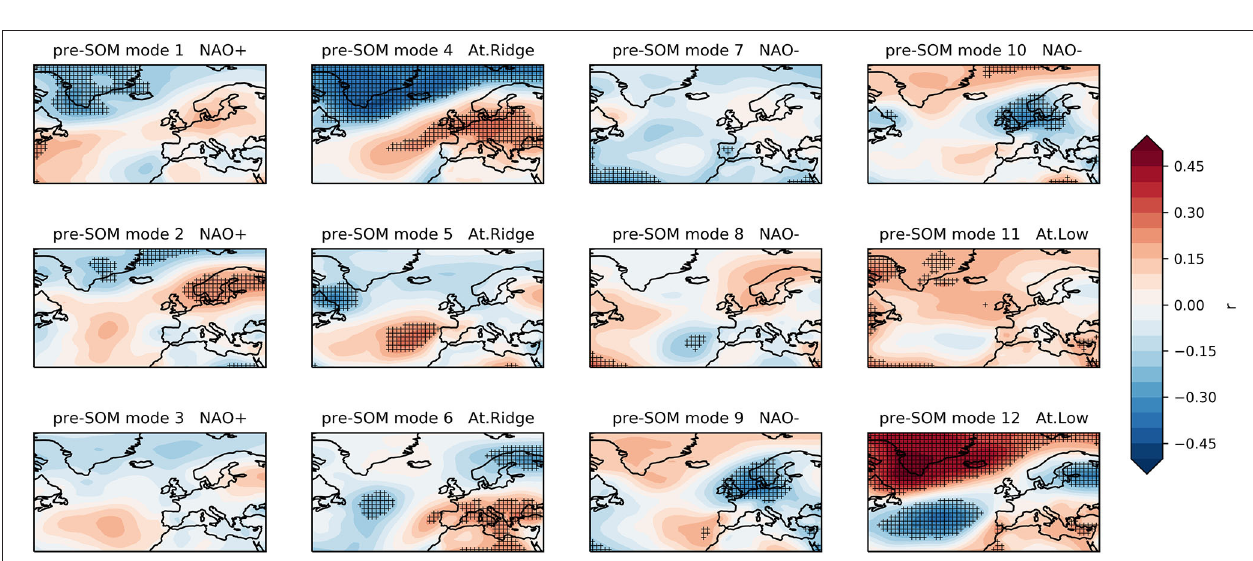
FIGURE 4 | Spring sea surface temperature (April SST) predictor patterns in the reanalysis with respect to the SOM master ( Figure 2 ), for the period 1902–2008. Each pattern of SST precedes a summer SOM mode, as labeled.